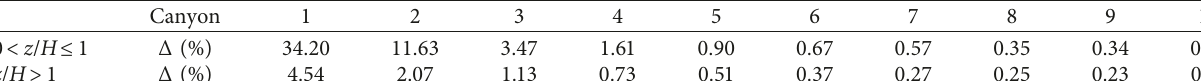
Table 2: Percentage differences between the velocity magnitudes calculated along the vertical profiles passing through the center of two contiguous canyons.